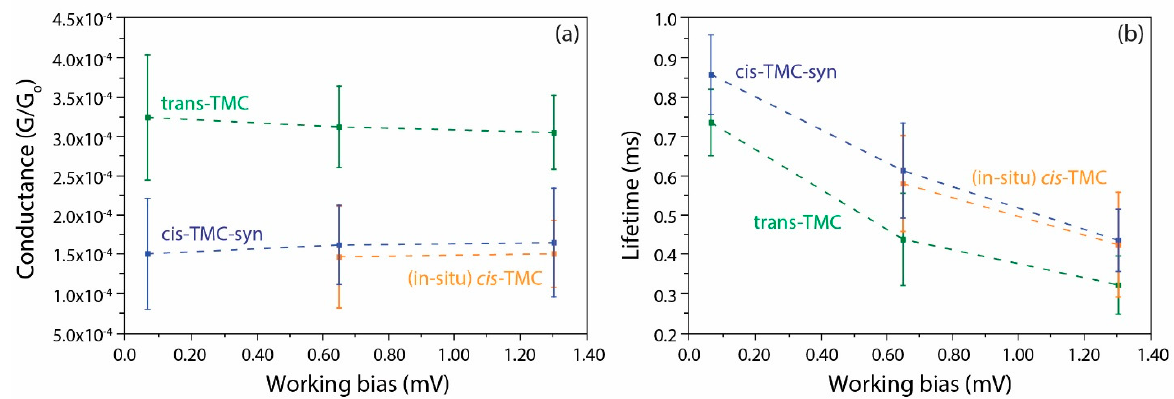
Figure A6. ( a ) Molecular conductance and ( b ) blinking lifetimes for trans-TMC HC (green) and LC (orange) as well as for cis-TMC-syn (blue) junctions for the three employed V bias values. Conductance and standard deviation values are extracted with Gaussian fits of the peaks in 1D blinking histograms of Figures 3 and